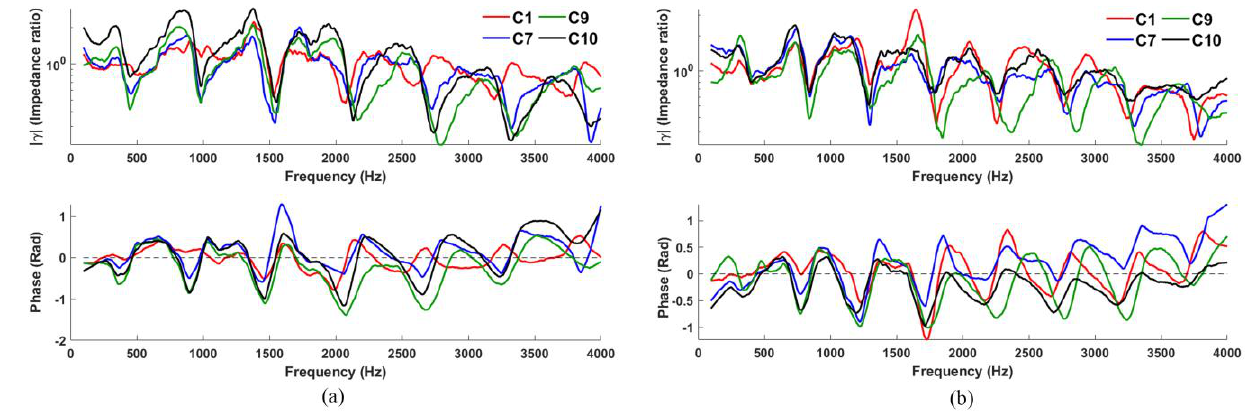
Figure 9. Comparison between C1, C7, C9, and C10 for a pipe length of ( a ) 283 and ( b ) 340 mm.